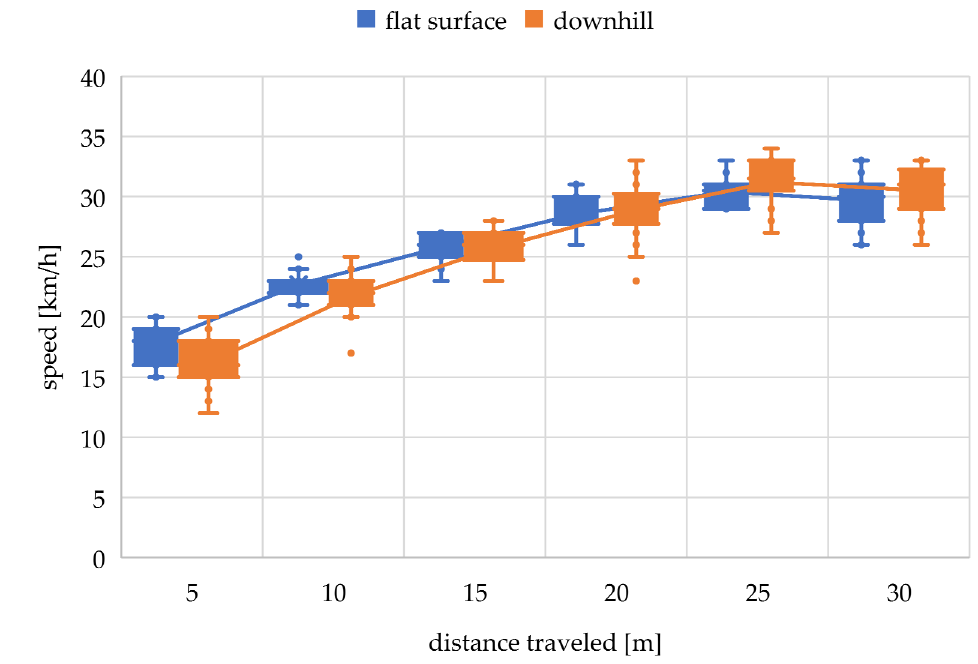
Figure 2. Comparison of speeds when driving on a flat surface and when driving downhill. Source: author.